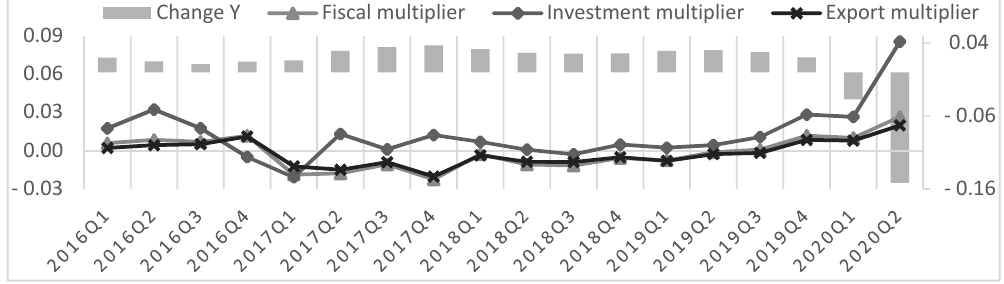
Figure 8. Changes in autonomous expenditure multipliers and GDP—France, own work, source: Eurostat.